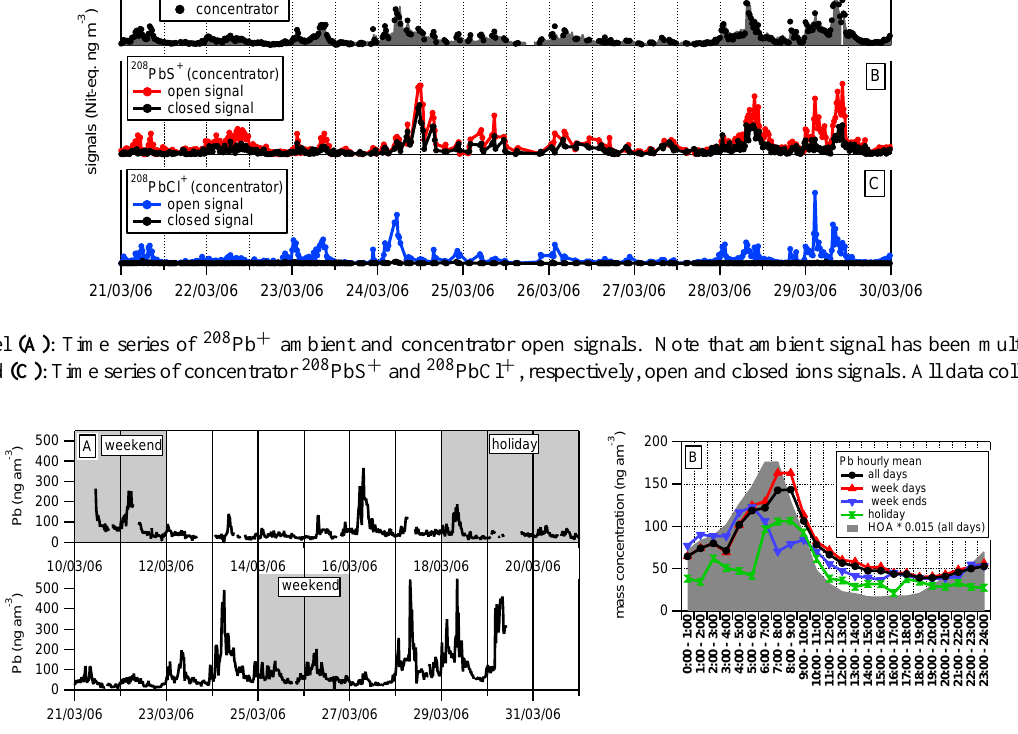
Fig. 11. Panel (A) : Time series of Pb mass concentration at T0 showing weekend and holiday periods during the measurement. Panel (B) : Diurnal cycle of total Pb mass concentration for all days, week day, weekends and holidays, compared to the PMF AMS factor, HOA (Aiken et al., 2009) which is a marker for primary organic